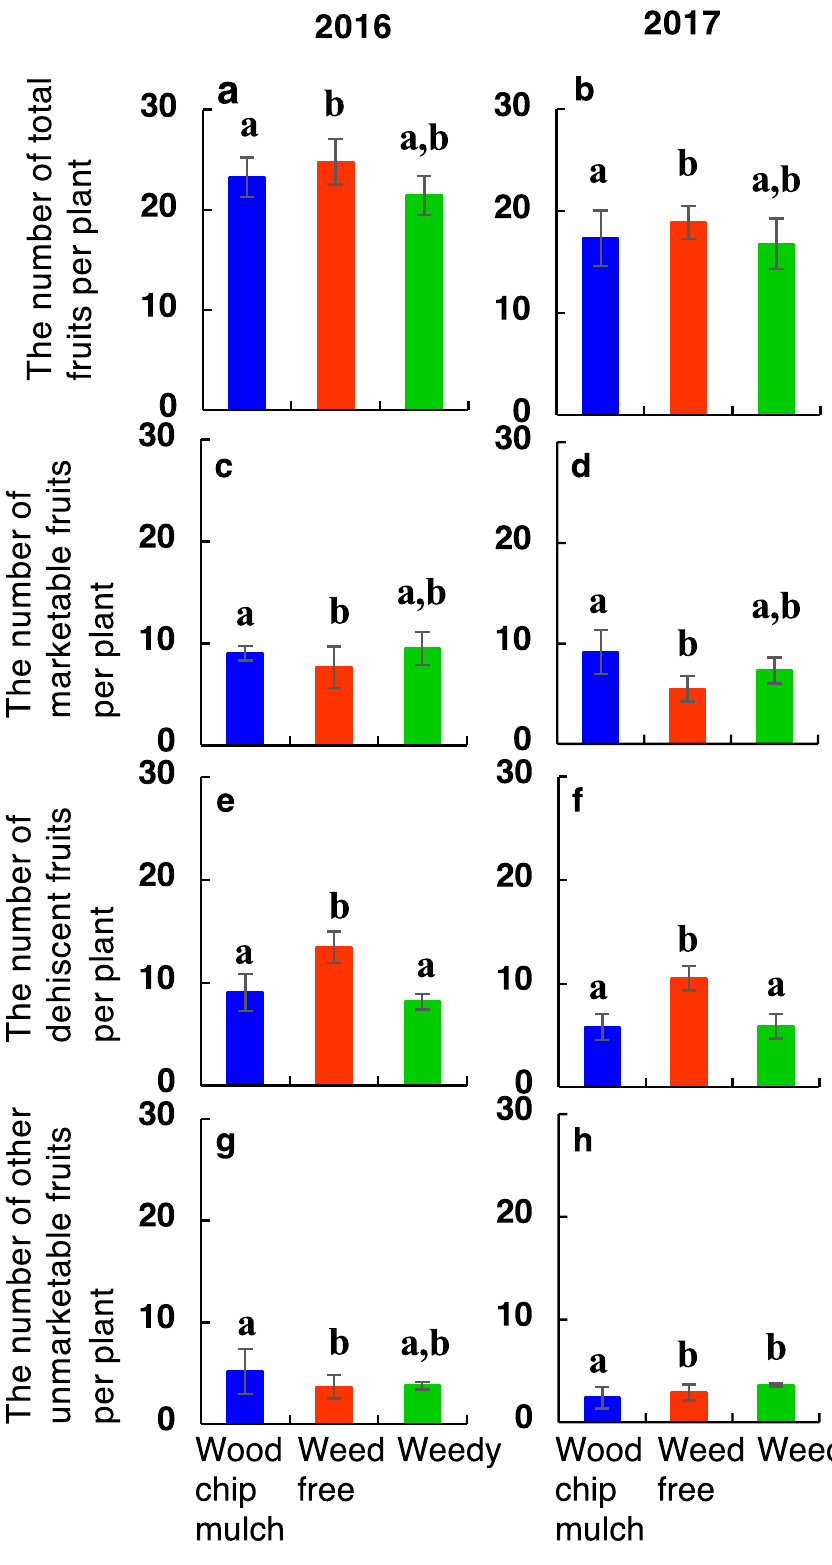
Figure 5. The total number of harvested tomato fruits per plant. ( a , b ) Total fruits, ( c , d ) fresh-marketable fruits, ( e , f ) dehiscent fruits and ( g , h ) the other unmarketable fruits per plant ( a , c , e , g ) in 2016 and ( b , d , f , h ) in 2017. The mean values in the woodchip mulch (blue), weed-free (red) and weedy (green) treatments are shown. Error bars show ± 1 S.D. Different letters just above the vertical vars in each panel show significant differences ( P < 0.05) among the treatments in each year. See Fig. 2 for harvested fruit